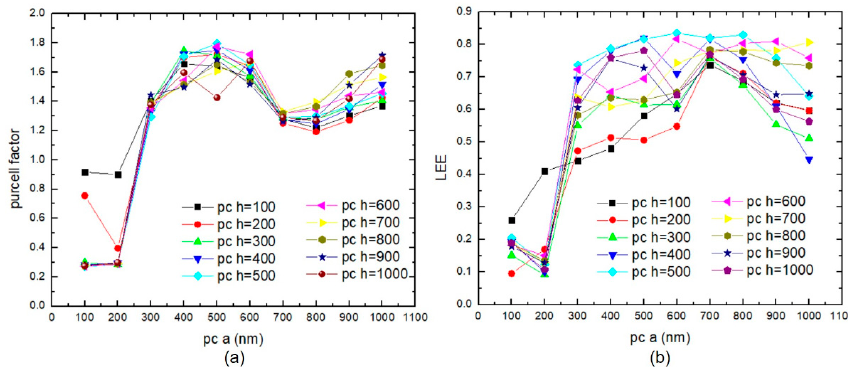
Figure 3. The trend of ( a ) Purcell factor and ( b ) LEE varying with the period and height of the photonic crystals when the duty cycle is 0.5.